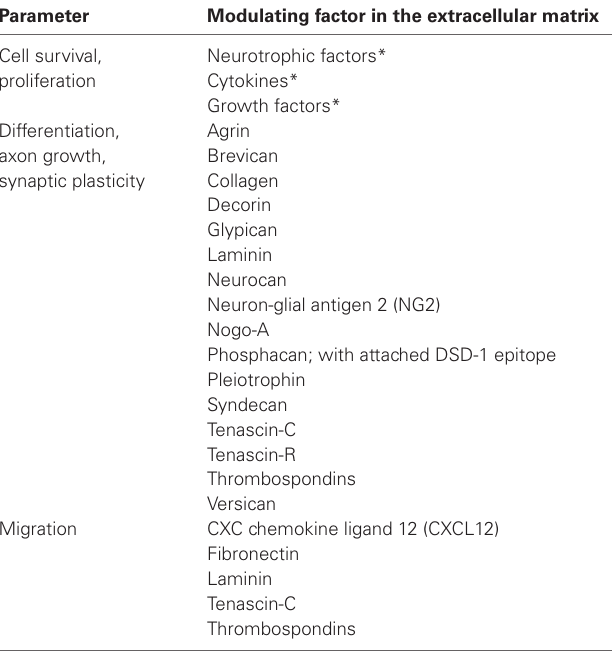
Table 2 | Parameters modulated by extracellular signals after lesion .